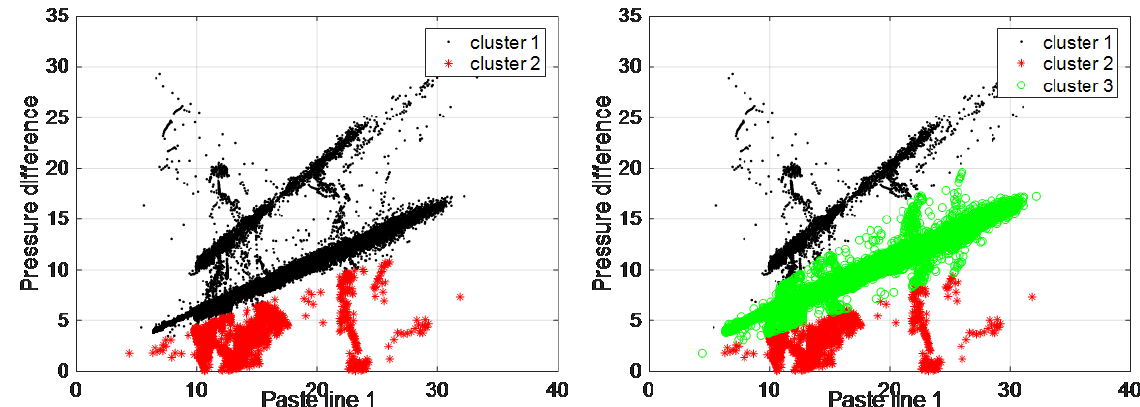
Figure 5: Clusters from variable Paste line 1 and response during the usage of booster pump KA7403; on the left there are the two cluster cases and on the right three cluster cases